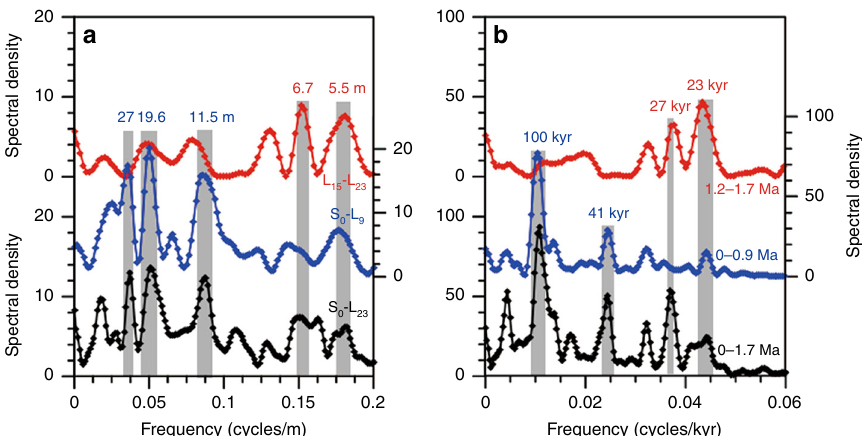
Fig. 4 Spectral results of JY δ 13 C IC record. a On depth scale, dominant cyclicity changes from 5.5 to 6.7 m/cycle below L 15 to 19.6-27 m/cycle above L 9 . b The dominant cyclicity on age scale is evidently shifted from 23-kyr before 1.2 Ma (below L 15 ) to 100-kyr after 0.9 Ma (above L